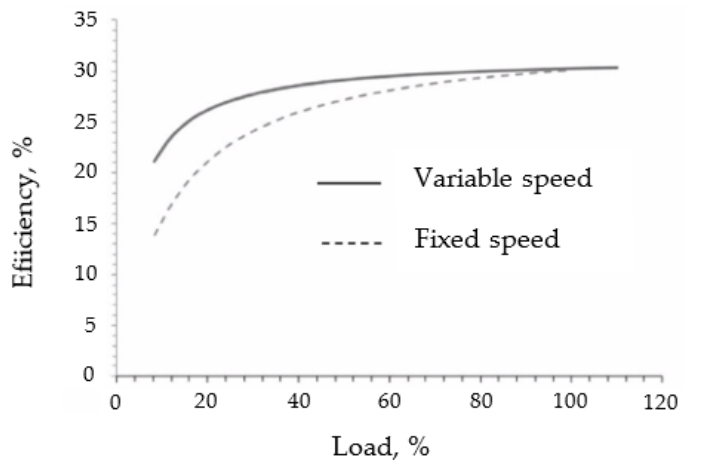
Figure 6. Variable and fixed speed DG efficiency at the load change. Adapted from Ref. [12].